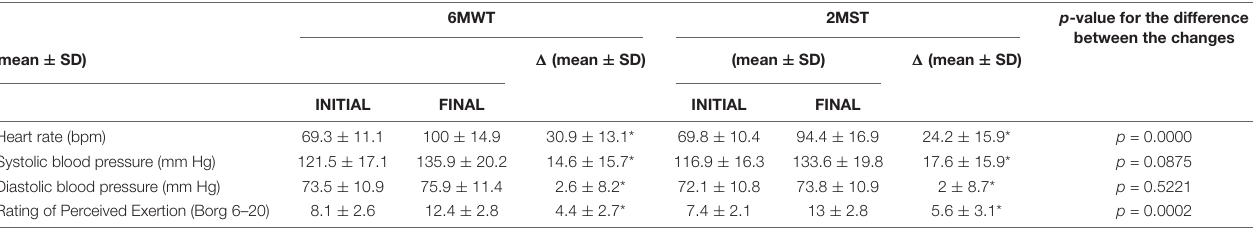
TABLE 2 | Heart rate, rating perceived exertion, and blood pressure pretests and